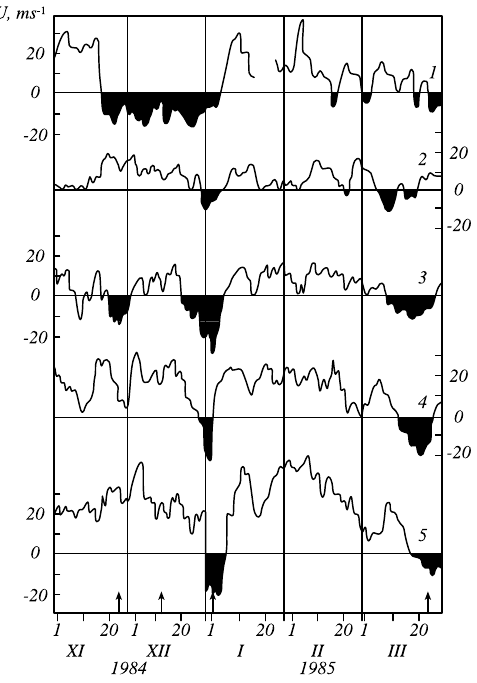
Fig. 8. The response of the prevailing zonal wind (U m/s) in the lower ionosphere on the stratospheric warmings during winter 1984-1985 (rather low solar activity). Positive direction - eastward. Arrows - days of stratospheric warmings (Kazimirovsky et al ., 1988). 1 - Observatory Badary, East Siberia, 52 °